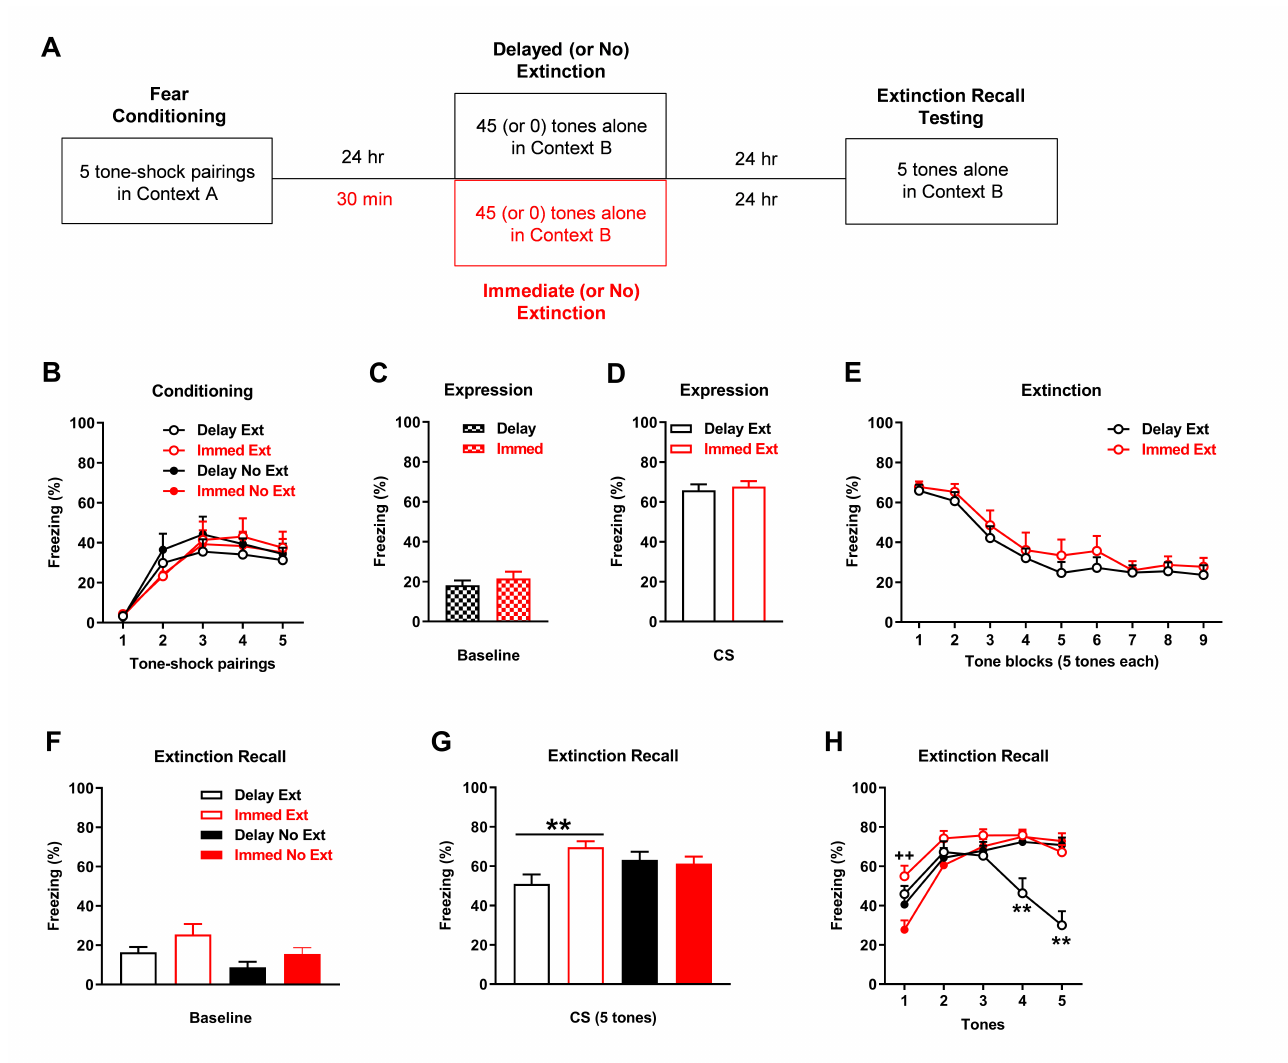
Figure 2. Validation of the immediate extinction deficit procedure. ( A ) Schematic representation of the behavioural testing procedures used. ( B ) Freezing in response to tone-shock pairings during fear conditioning. There were no differences in freezing between the groups (n = 10/group) to later undergo delayed (Delay) or immediate (Immed) extinction (Delay Ext, Immed Ext) or no extinction (Delay No Ext, Immed No Ext). ( C ) Freezing before tone presentations (Baseline) during Delay or Immed (or no) extinction. There were no differences in freezing between Delay (Ext and No Ext combined) and Immed (Ext and No Ext combined). ( D ) Freezing in response to the first block of tones at the start of Delay Ext or Immed Ext. There were no differences in freezing between Delay Ext and Immed Ext. ( E ) Tone-induced freezing during Delay Ext and Immed Ext. There were no differences in freezing between Delay Ext and Immed Ext. ( F ) Freezing before tone presentations (Baseline) during extinction recall. Freezing was increased with Immed, compared to Delay, and with Ext, compared to No Ext ( p < 0.05). ( G ) Tone-induced freezing across extinction recall testing. Freezing was increased with Immed Ext, compared to Delay Ext (** p < 0.01). ( H ) Freezing in response to each tone during extinction recall testing. Freezing was increased with Imm Ext, compared to Imm No Ext, during tone 1 ( ++ p < 0.01). Freezing was also decreased with Delay Ext, compared to Immed Ext and Delay No Ext, during tones 4-5 (** p <